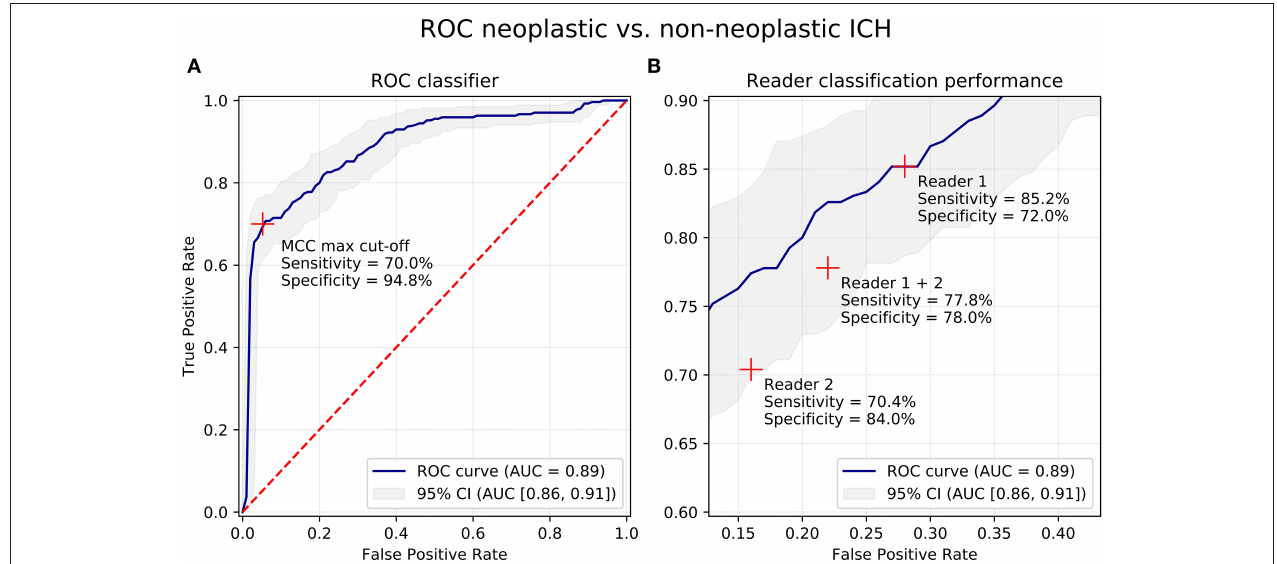
FIGURE 2 | Receiver-Operating-Characteristics curves for differentiation of neoplastic and non-neoplastic ICHs. (A) Receiver-Operating-Characteristics (ROC) curves for differentiation of neoplastic and non-neoplastic ICHs of the proposed machine learning classifier based on quantitative radiomic image features. (B) Cut-out of panel (A) showing classification results of human reader 1 and 2. Blue line shows ROC curve, grey area shows 95% confidence interval (CI). Red crosses show cut-off points/prediction performance. AUC, area under the curve; CI, confidence interval; ROC, Receiver-Operating-Characteristics; ICH, intracerebral hemorrhage; MCC, Matthews correlation